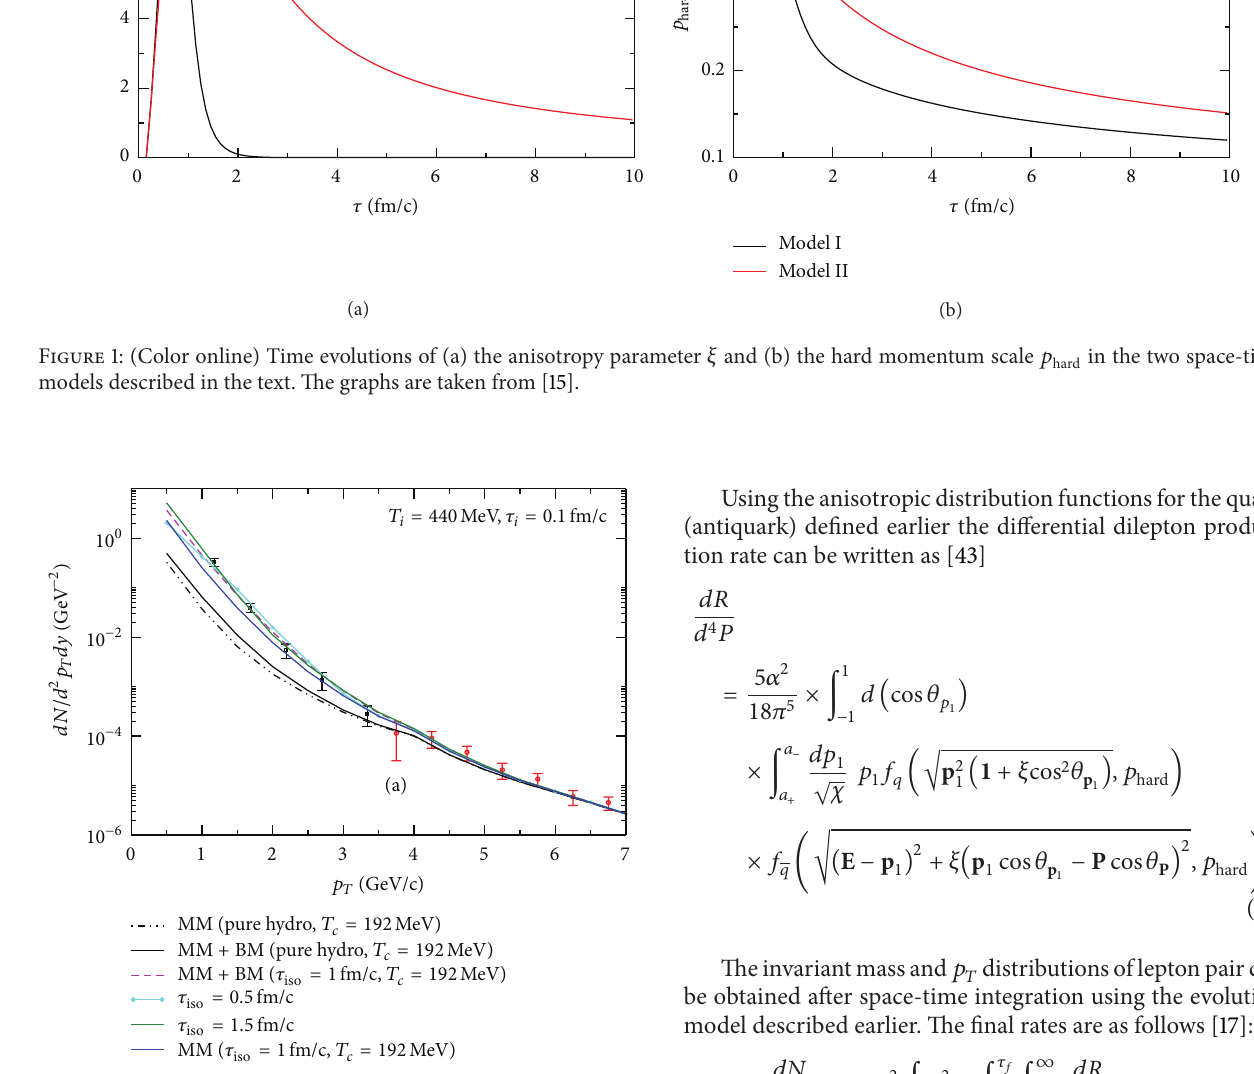
Figure 2: (Color online) Photon transverse momentum distribu- tions at RHIC energies. The initial conditions are taken as 𝑇 𝑖 = = 0.1 fm/c, and 𝑇 = 192 MeV [16]. 440 MeV, 𝜏 𝑖 𝑐